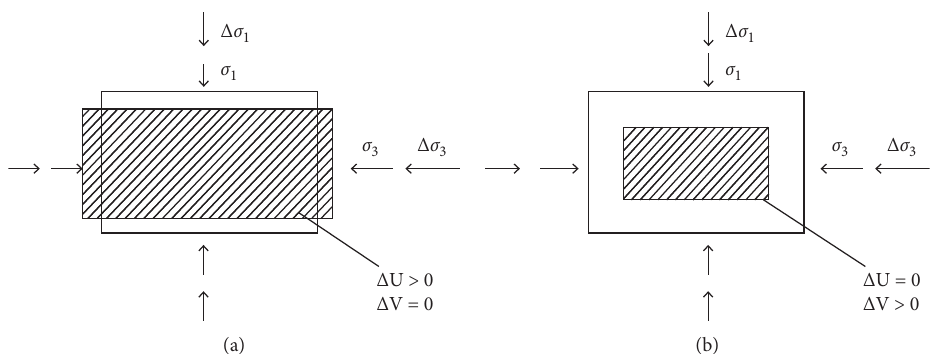
Figure 15: Micromechanism of lateral deformation of soil.